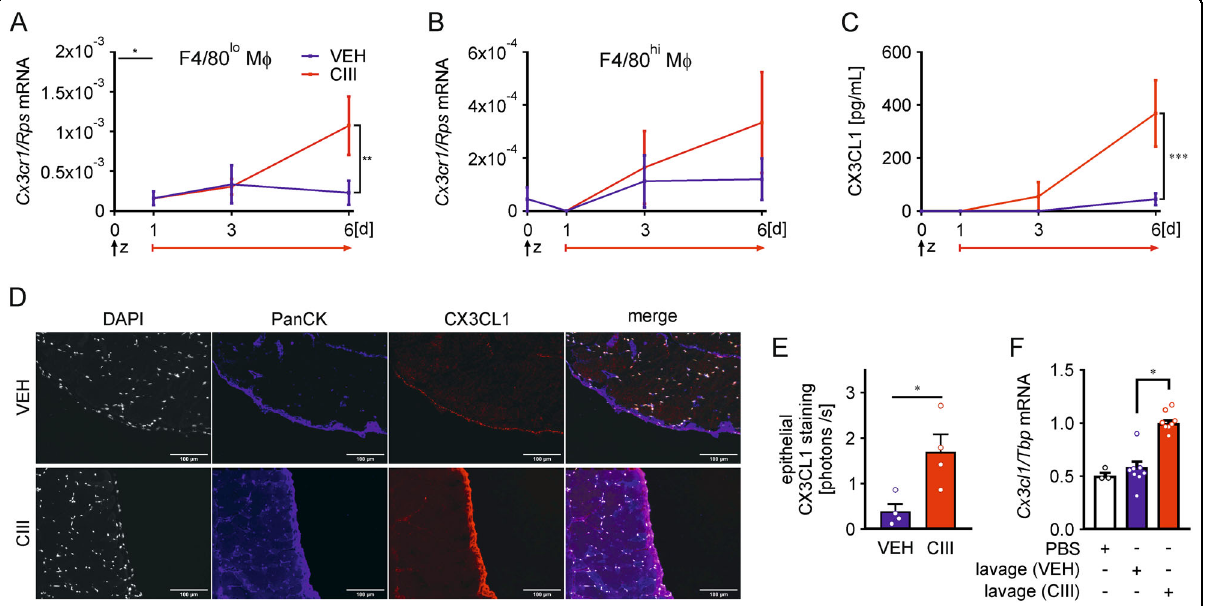
Fig. 3 Inhibition of mPGES-1 enhances expression of the CX3CR1/CX3CL1 axis during resolution of in fl ammation. Starting 24 h post i.p. zymosan (5 mg/kg) injection, mice received daily i.p. injections of the mPGES-1 inhibitor compound III (CIII) (25 mg/kg) or the appropriate vehicle control (VEH). Cx3cr1 mRNA expression in A F4/80 lo and B F4/80 hi macrophages (M ϕ ) was analyzed by RT-qPCR analysis. C Concentrations of CX3CL1 in the peritoneal lavage were determined by ELISA. D Representative pictures of peritoneal membranes from VEH- and CIII-treated animals at day 6 using multiplexed IHC staining for the epithelial marker pan-cytokeratin (PanCK), CX3CL1, and DAPI. E Quanti fi cation of CX3CL1 staining intensity in PanCK-expressing epithelial cells using the InForm-software. F Epithelial E0771 cells were treated with medium supplemented with peritoneal lavages obtained from VEH- or CIII-treated mice at day 6 of the peritonitis model for 4 h. Cx3cl1 mRNA expression was analyzed by RT-qPCR. Data are represented as means ± SEM ( n ≥ 4 per group). For statistical analysis within each treatment, t test or one-way ANOVA with Holm – Sidak posthoc test was used for parametric data, otherwise, Kruskal – Wallis test was used. Analysis between the treatments for parametric data was done via two-way ANOVA with Holm – Sidak posthoc test, non-parametric data were log-transformed (* p < 0.05, ** p < 0.01, *** p <